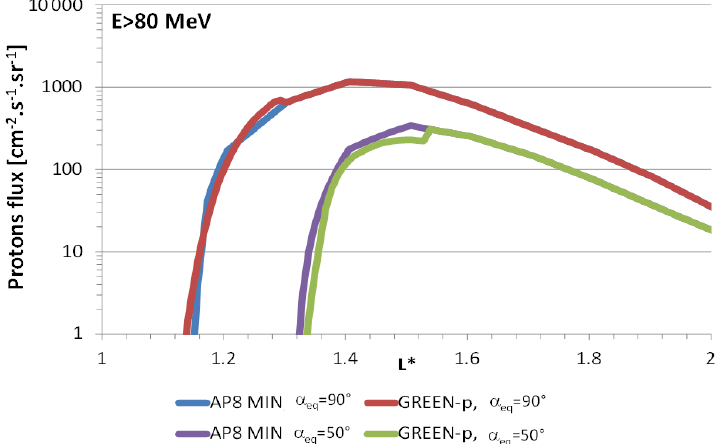
Figure 19. Proton fluxes vs. L ∗ resulting from GREEN- p and AP8 MIN at two magnetic latitudes corresponding to α eq = 90 ◦ and α eq = 50 ◦ for E >80MeV